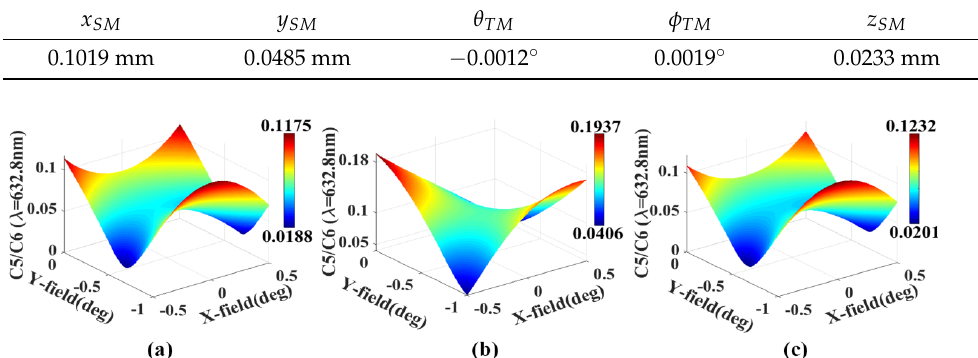
Table 2. The calculated compensation adjustments for SM.